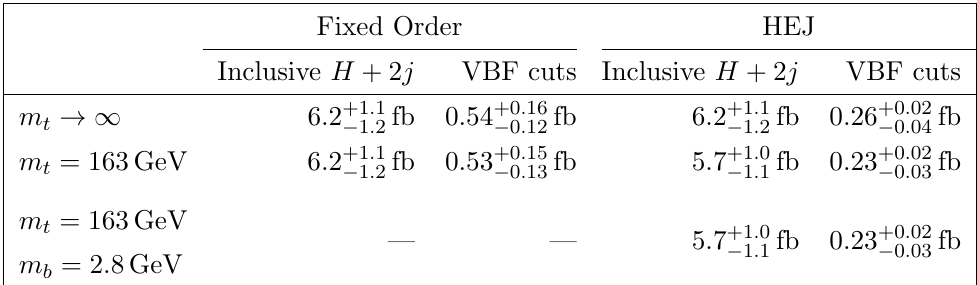
Table 2 . Cross sections obtained in (cid:12)xed order perturbation theory (either full NLO for the results using in(cid:12)nite top-quark mass or LO scaled bin-by-bin with the K -factor obtained in the in(cid:12)nite top-quark mass limit) and in HEJ for pp H + 2 j with inclusive and VBF-cuts. See text for ! further comments.